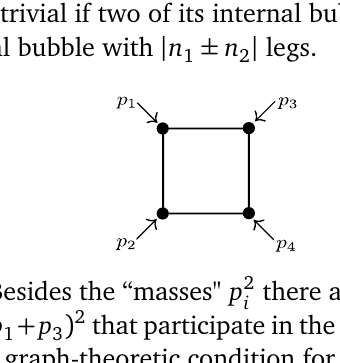
and n legs, are 1 2